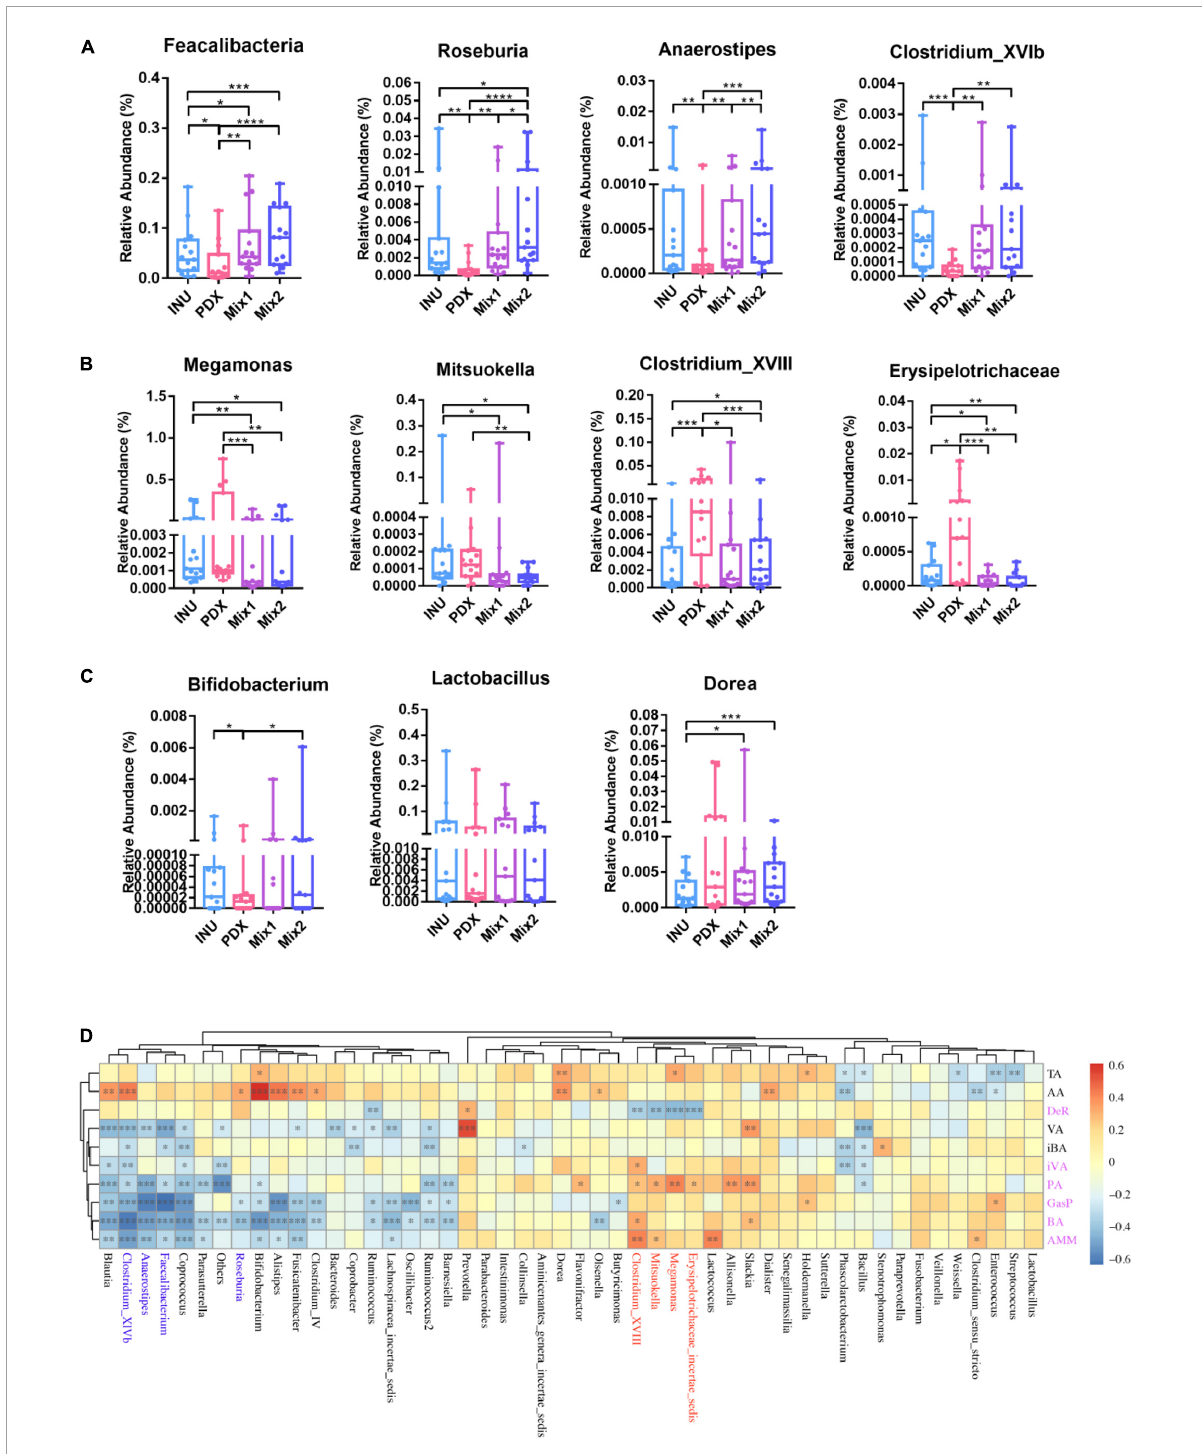
FIGURE5 Differential genera between PDX and inulin or their blends and their contribution to metabolites. (A) The genera in PDX with 2-fold lower relative abundance than in inulin (INU) or their blends. (B) The genera in PDX with 2-fold higher relative abundance than in INU or their blends. (C) The genera with a less than 2-fold change abundance between PDX and INU or their blends. (D) Heatmap of the correlations with the top 50 genera and the metabolites revealed by Spearman’s rank coefficient correlation analysis. Three genera in panel (A) are shown in blue and in panel (B) are in red. The metabolites with significant differences between PDX and INU or their blends were in purple. TA, total SCFAs, AA, acetate, DeR, degradation rate, VA, valerate, iBA, isobutyrate, iVA, isovalerate, PA, propionate, GasP, gas production, BA, butyrate,